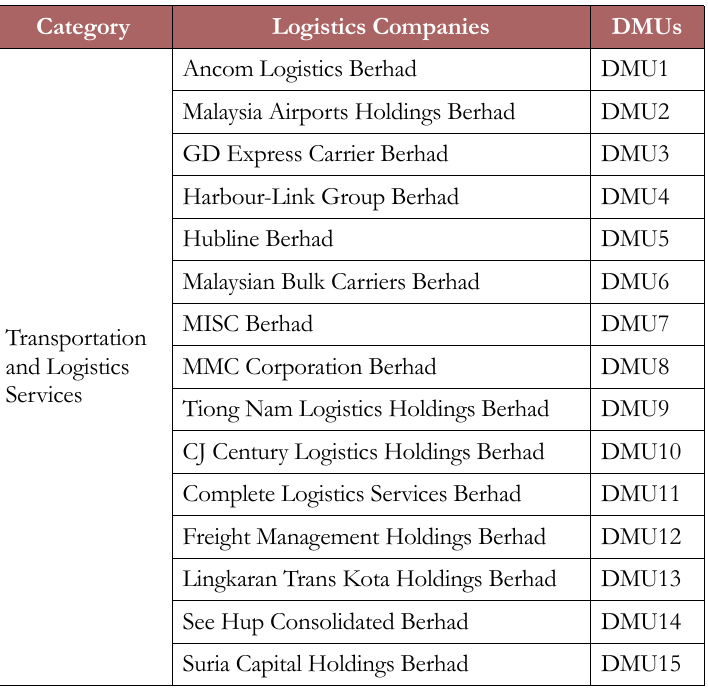
Table 1. DMUs for the study